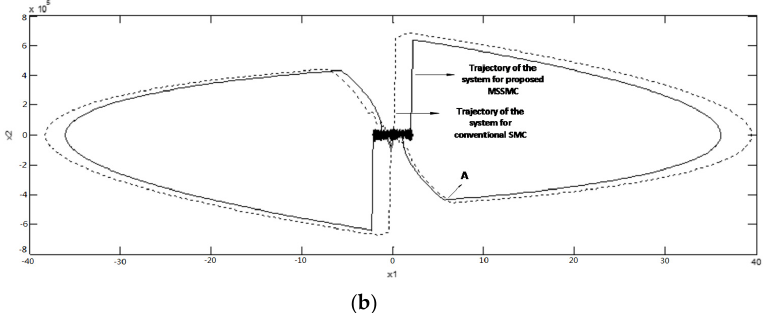
Figure 11. State trajectories in the phase plane: ( a ) state trajectories in the phase plane obtained by conventional and proposed controller; and ( b ) state trajectories in the phase plane obtained by conventional and proposed SMC controller.